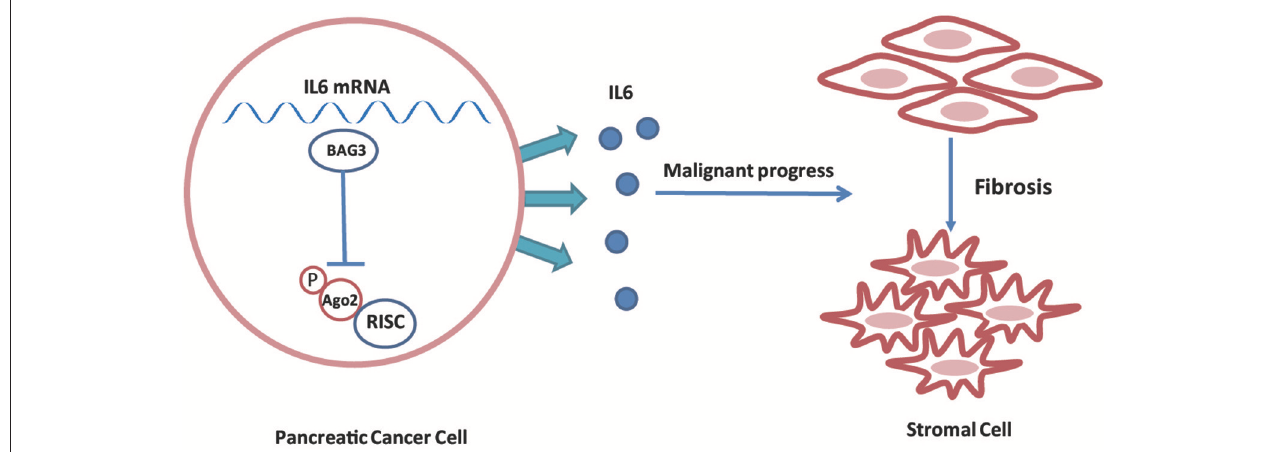
FIGURE 7 | Schematic representation of that BAG3 expression levels in PDACs regulate their ability to drive PSCs activation via regulating stability of IL6 mRNA.